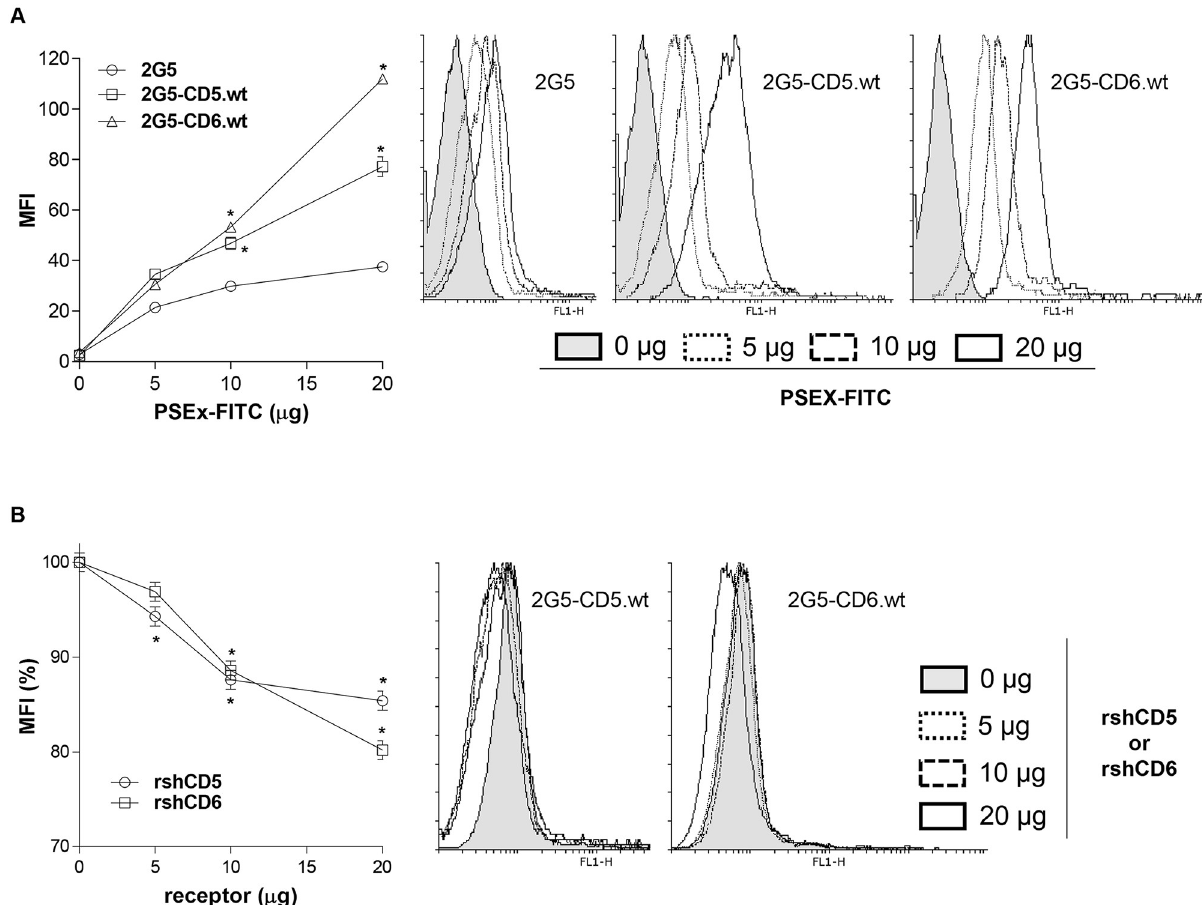
Fig 3. Native membrane-bound CD5 and CD6 receptors retain PSEx-binding capacity. ( A ) Flow cytometry analyses of 2G5, 2G5-CD5.wt or 2G5-CD6.wt cells stained with increasing amounts of FITC-labeled PSEx. Represented are the mean fluorescence intensity (MFI) values ( left ) and a representative flow cytometry histogram from each case ( right ). ( B ) Competition binding experiments in which 2G5-CD5.wt or 2G5-CD6.wt cells were stained with a fixed suboptimal amount of FITC-labeled PSEx in the presence or absence of different amounts of unlabeled rshCD5 or rshCD6 proteins. Both experiments were performed in quadruplicates and results are shown as mean +/- SD. ( � ) Significant differences (Student’s t-test, P < 0.05) respect to 2G5 cells ( A ) or cells with 0 μ g of competing proteins ( B ).